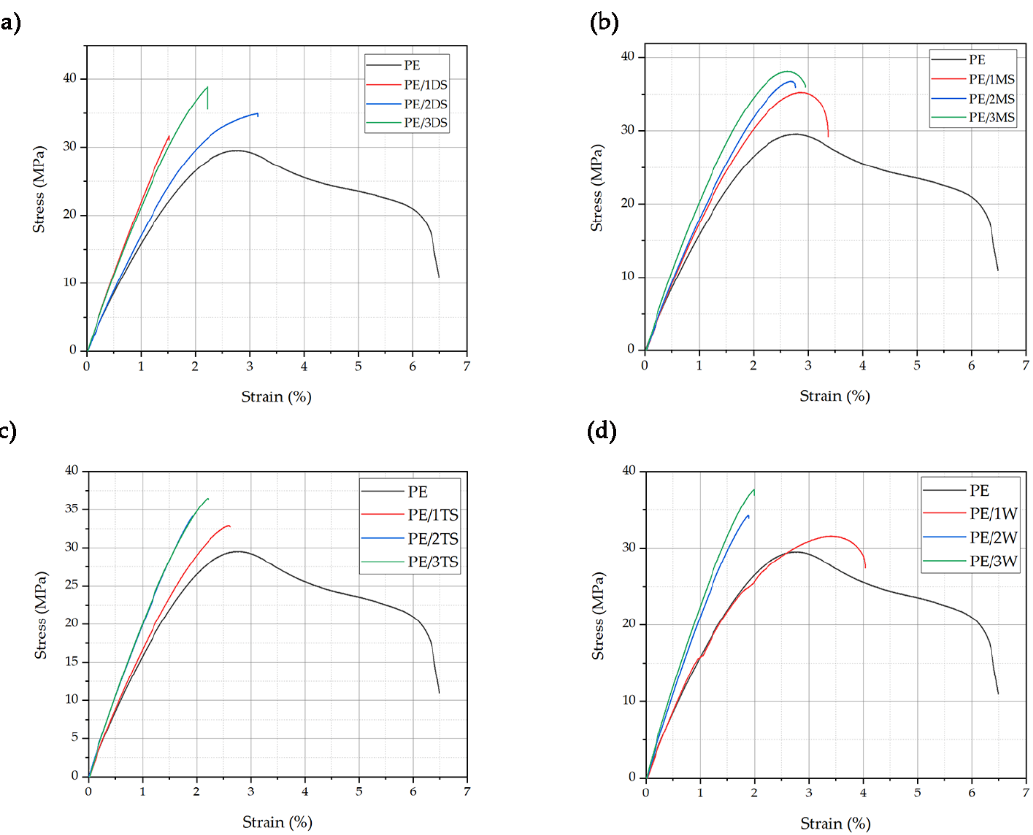
Figure 7. Comparison of stress–strain curves of PE and ( a ) PE/1DS, PE/2DS, PE/3DS; ( b ) PE/MS, PE/2MS, PE/3MS; ( c ) PE/1TS, PE/2TS, PE/3TS; and ( d ) PE/1W, PE/2W, PE/3W specimen.